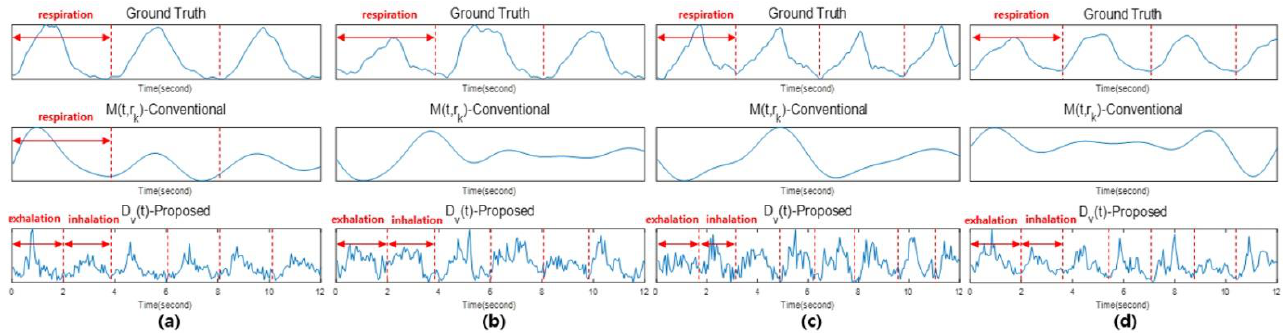
Figure 7. Comparison of 𝐷 𝑣 (𝑡) and 𝑀(𝑡, 𝑟 𝑘 ) . ( a ) Leaning against the wall; ( b ) without leaning against the wall; ( c ) moving forward and backward; ( d ) moving left and right.